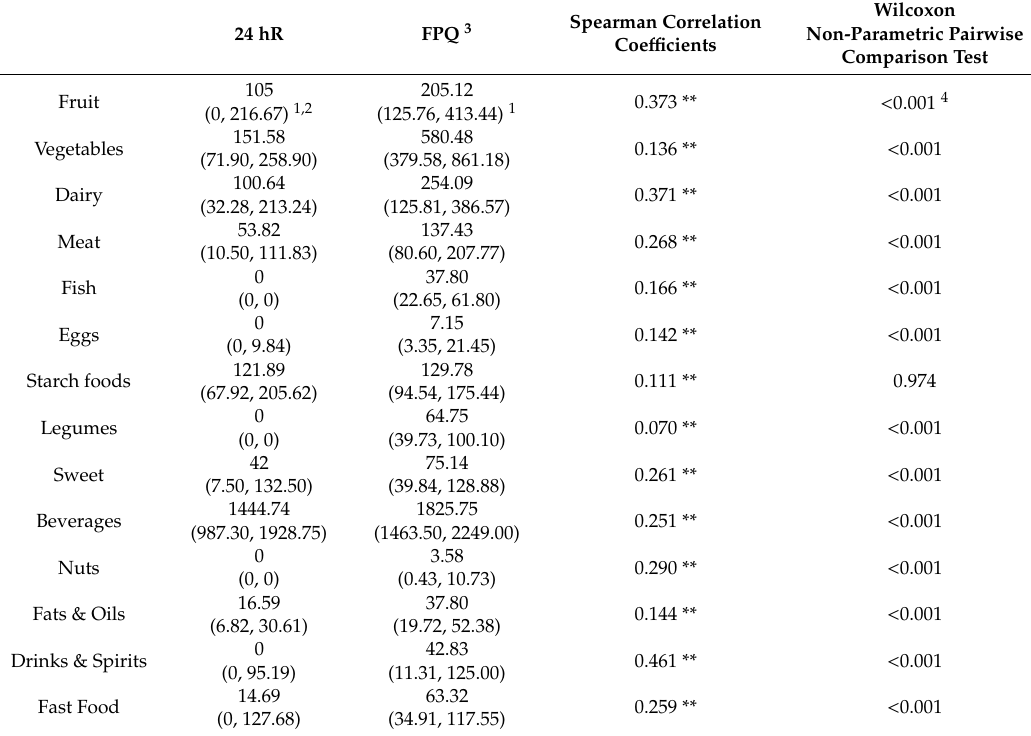
Table 3. Distribution of the Consumption of the Foods and Beverages in the Validation Study and Results from the Wilcoxon non-parametric pairwise comparison test and Spearman correlation coe ffi cients Analysis of Validity.